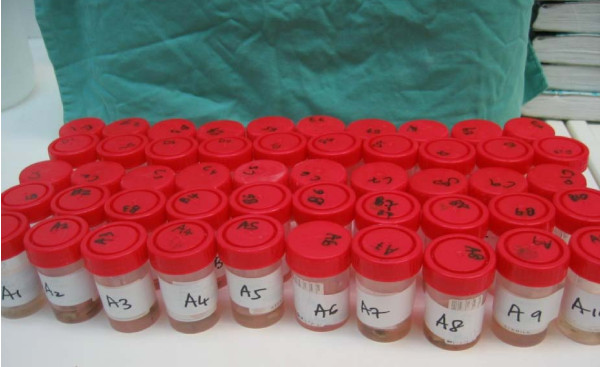
Histopathological samples in formalin filled containers.